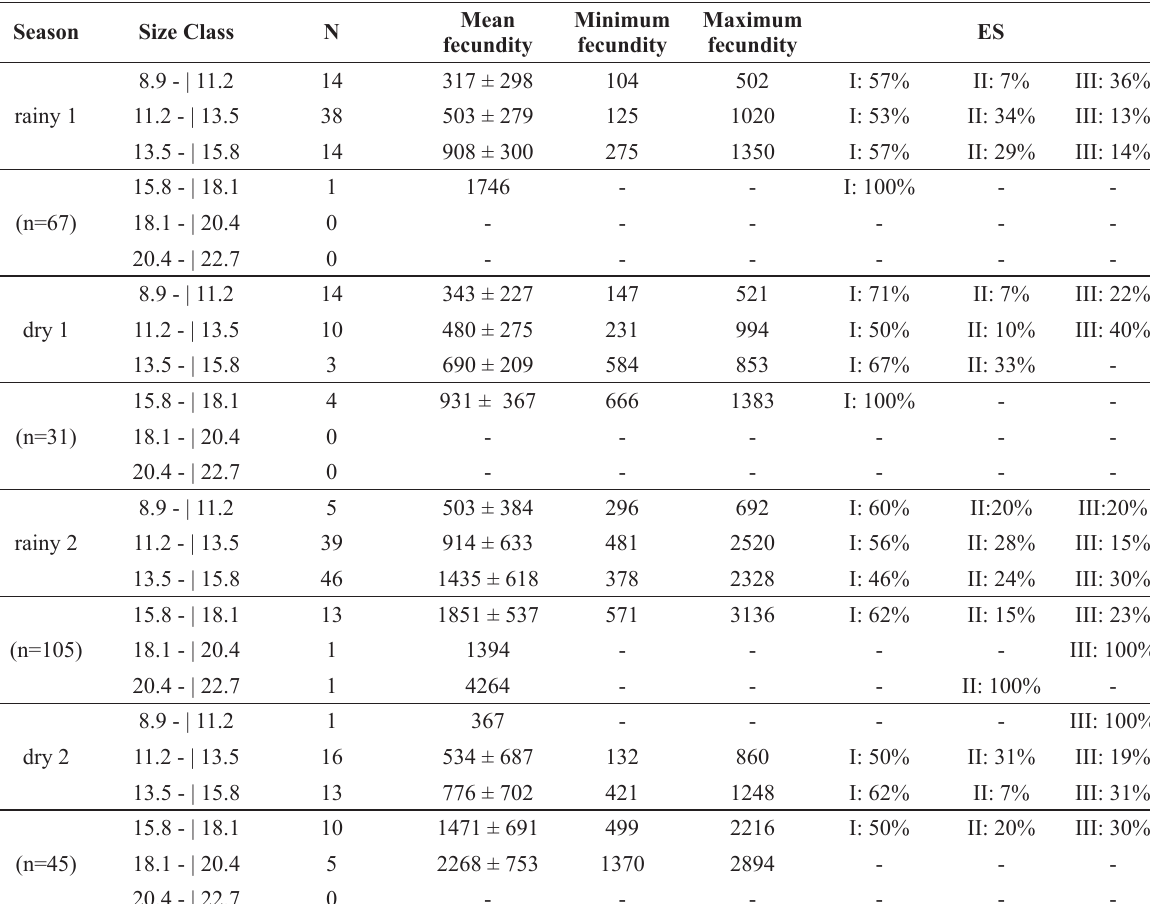
Fecundity and variation in percentage of females per egg stage (ES) of Macrobrachium amazonicum (Heller, 1862), according to size classes of females with embryos analyzed and sampled season. Results expressed by mean ± standard